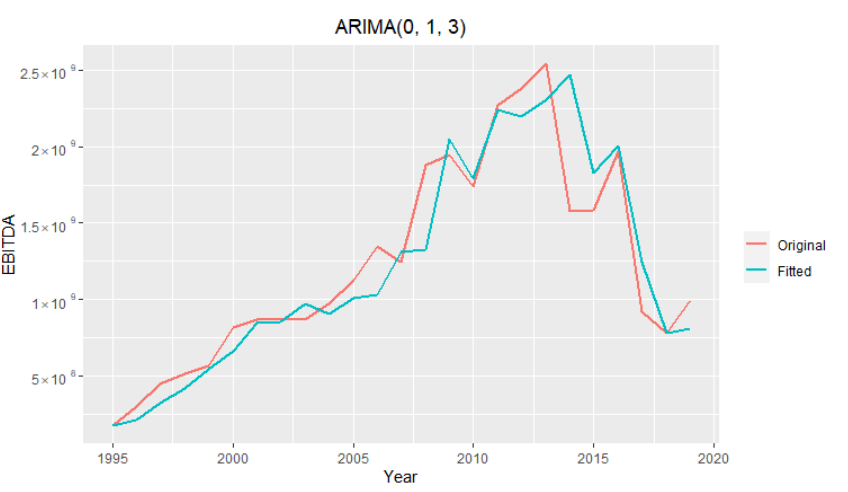
Figure 7. Fitted ARIMA model for the EBITDA